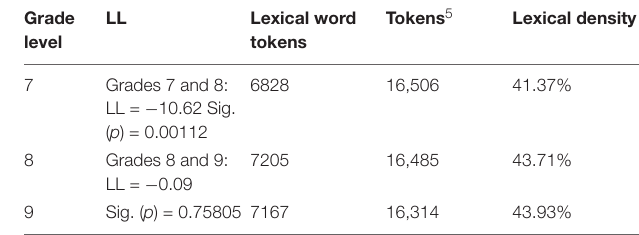
TABLE 5 | Lexical density per grade